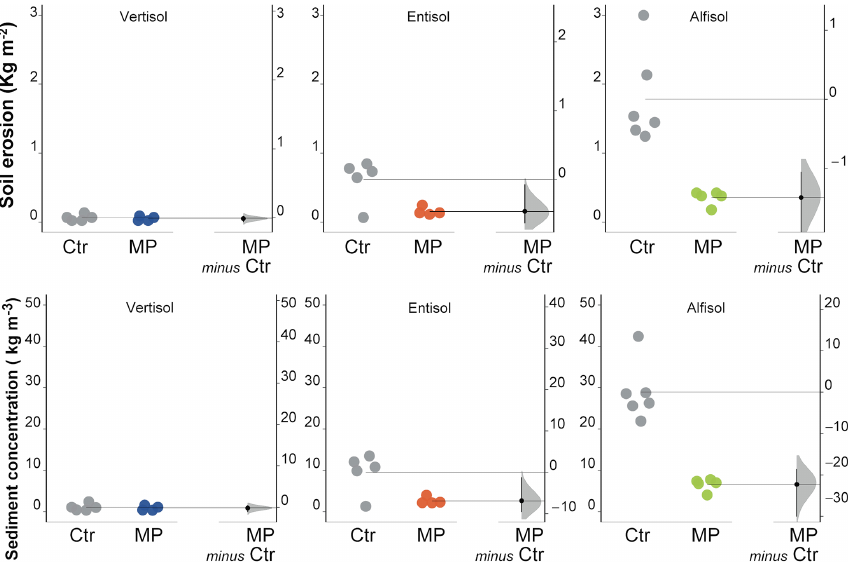
Figure 8. Soil erosion and sediment concentration. Raw data of control (Ctr, gray dots) and polyester MP fibers added treatment (MP, colored dots) are shown in the plot for each soil. The filled curve indicates the resampled distribution of the mean differences ( (cid:49) ), given the observed data. Horizontally aligned with the mean of the test group, (cid:49) is indicated by the black circle. The 95% confidence interval of (cid:49) is illustrated by the black vertical